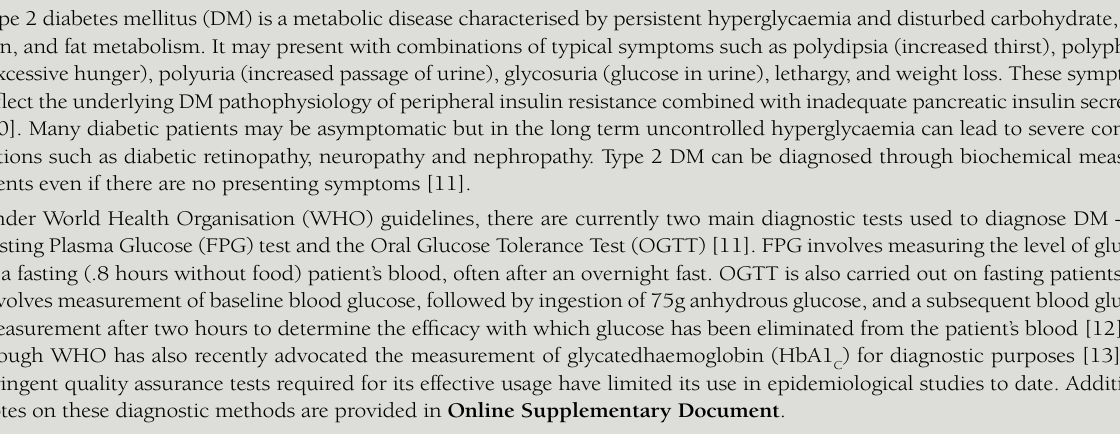
Table 1. World Health Organization's 2006 diagnostic criteria for type 2 diabetes